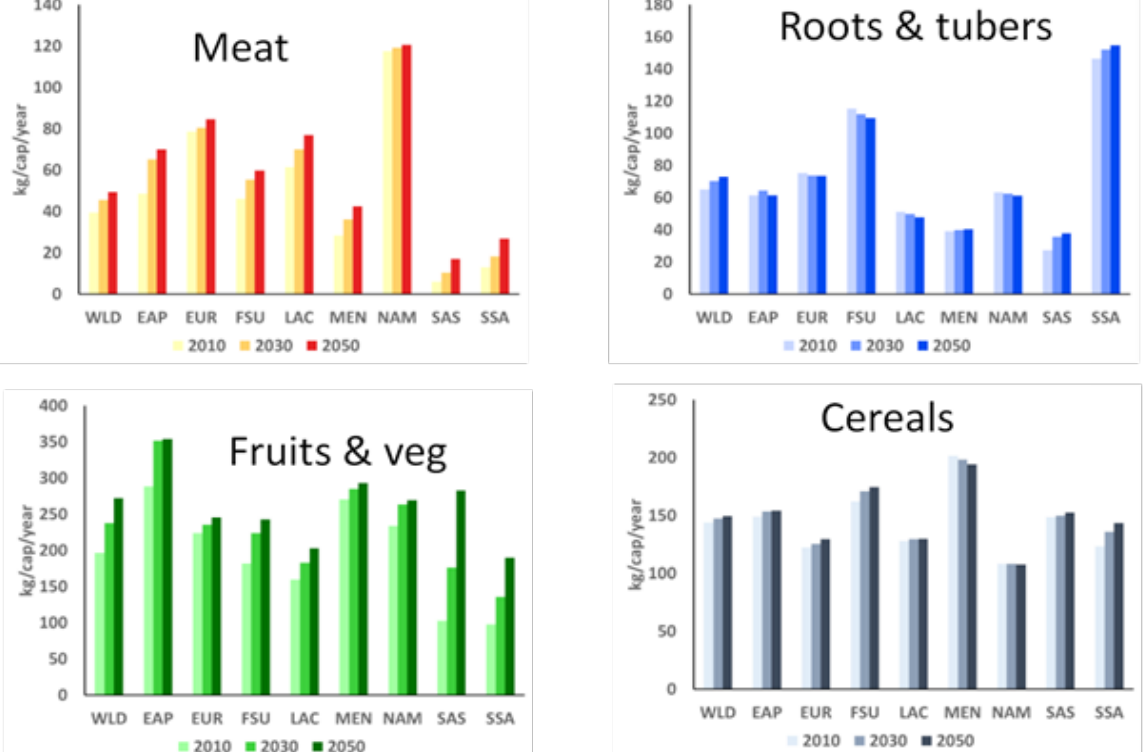
Figure 1: Forecast sustained per capita demand for roots and tubers to 2050 (source: K. Wiebe